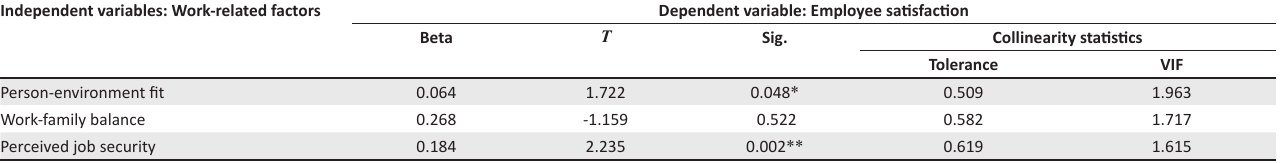
TABLE 5: Regression analysis – work-related factors and employee satisfaction. Independent variables: Work-related factors